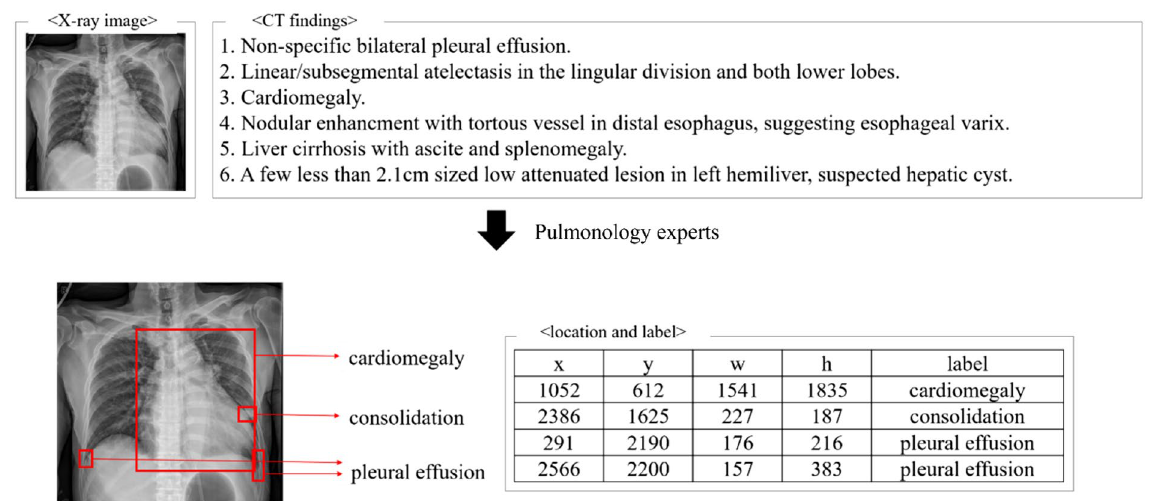
Figure 1. The schematic flow of data preprocessing. Each lesion of X-ray is labeled with a bounding box on the chest image by pairing one-to-one with the chest computed tomography description which was taken on the nearest time at exact same day. Each bounding box consists of the upper left x, y coordinates, width, height, and lesion class values. Bounding box was measured by trained pulmonology